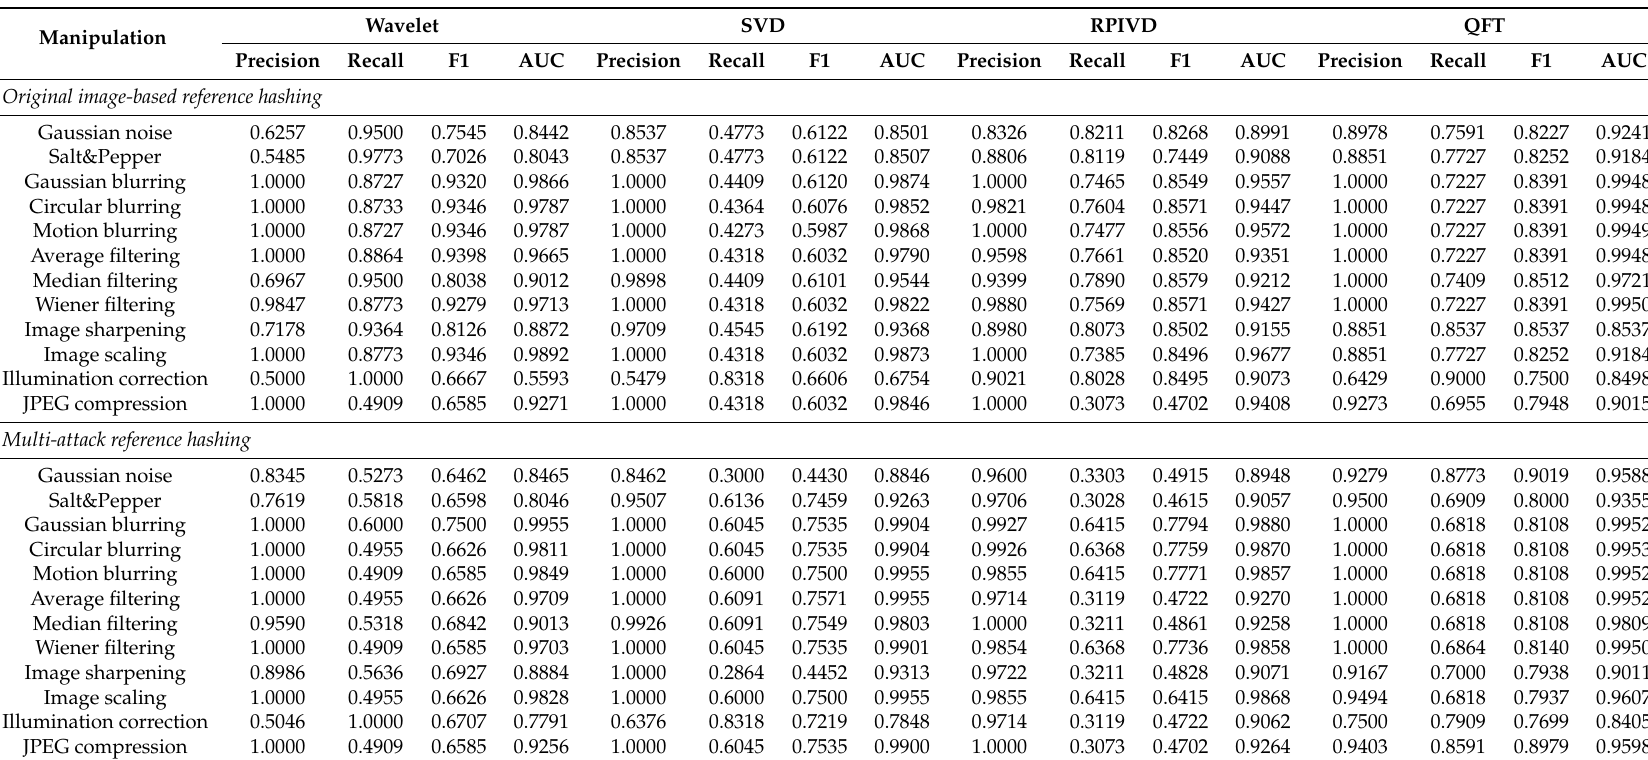
Table 2. Comparisons between the original image-based reference hashing and the proposed multi-attack reference hashing (RTD dataset). Wavelet SVD RPIVD QFT Manipulation Precision Recall F1 AUC Precision Recall AUC Precision Recall Precision Recall Original image-based reference hashing Gaussian